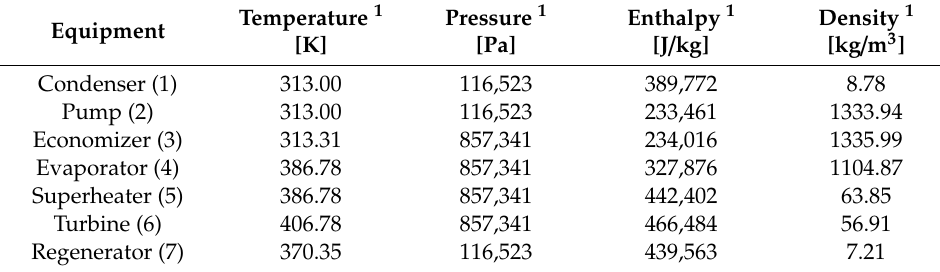
Table 5. SES36 thermodynamic parameters. Figure 2. Temperature–entropy diagram for the fluids considered in this study fluids, in the same scale as the usual water Mollier diagram.